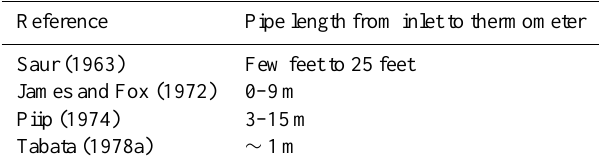
Table A2. Inlet-thermometer pipe lengths reported in the